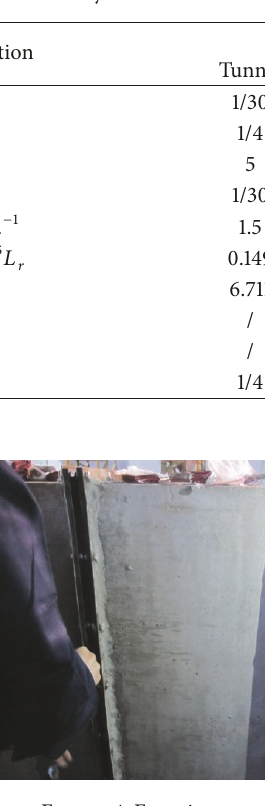
Figure 4: Experiment tunnel